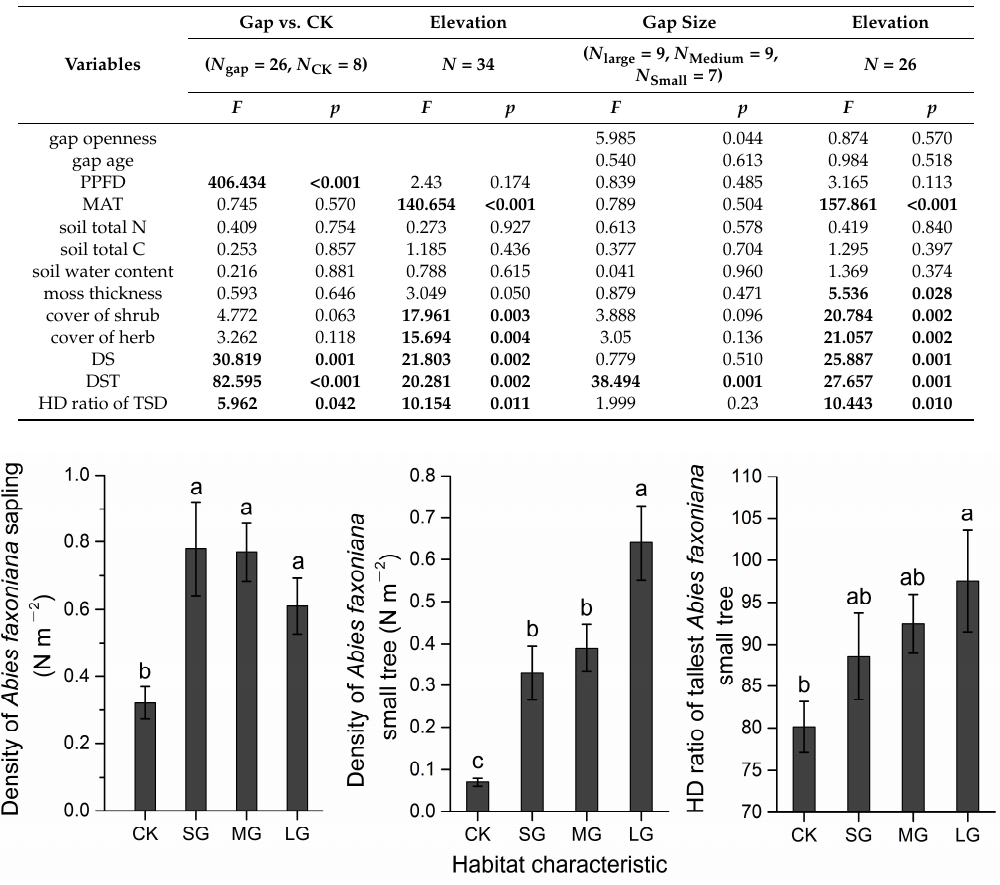
Table 2. MANOVA results comparing effects of gap vs. CK and gap size. F and p values are derived from analysis of variance. PPFD, MAT, DS, DST and HD ratio TSD represent photosynthetic photon flux density, mean annual temperature, density of Abies faxoniana saplings, density of Abies faxoniana small trees and HD ratio of the tallest Abies faxoniana small trees, respectively. Values in bold are different from 0 with a significance level alpha = 0.05.